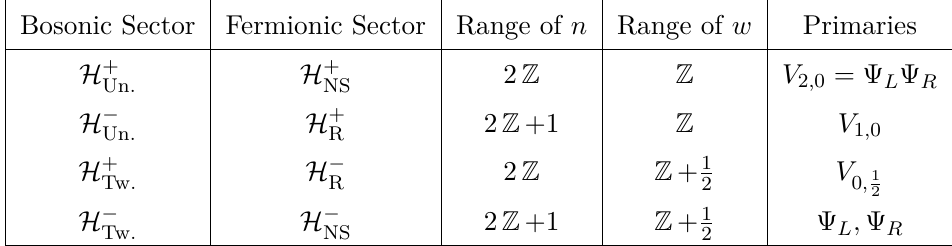
Table 2 . Bosonic and fermionic Hilbert spaces and their operators for the Z n comparing bosonic and fermionic Hilbert spaces for the S 1 [ R ] , S 1 [ R ] / Z n well as some of their local primaries. Reproduced from table 1. of